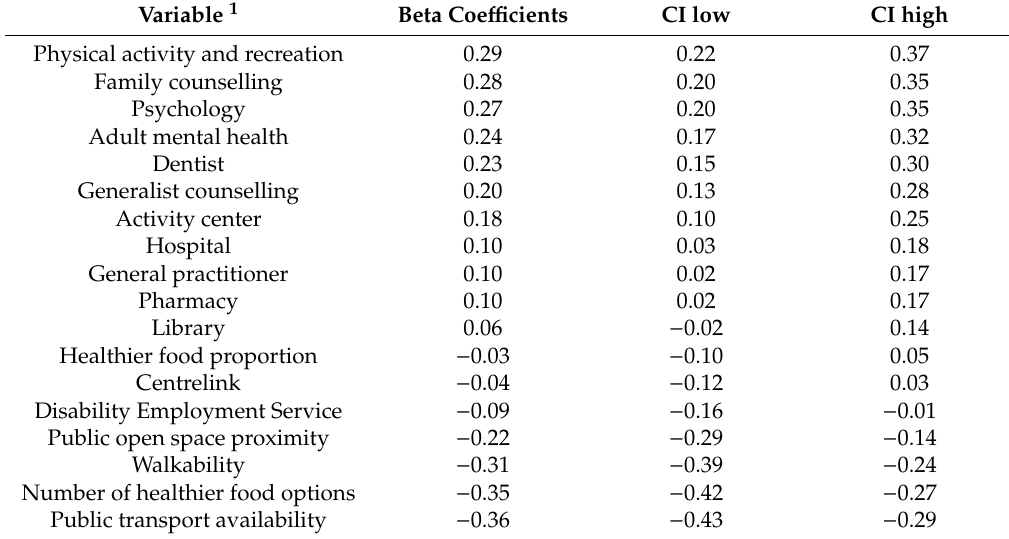
Table 2. Results from the linear regression for the association between built environment indicators (z-standardized variables) and SA2 disability prevalence for people aged 15–64